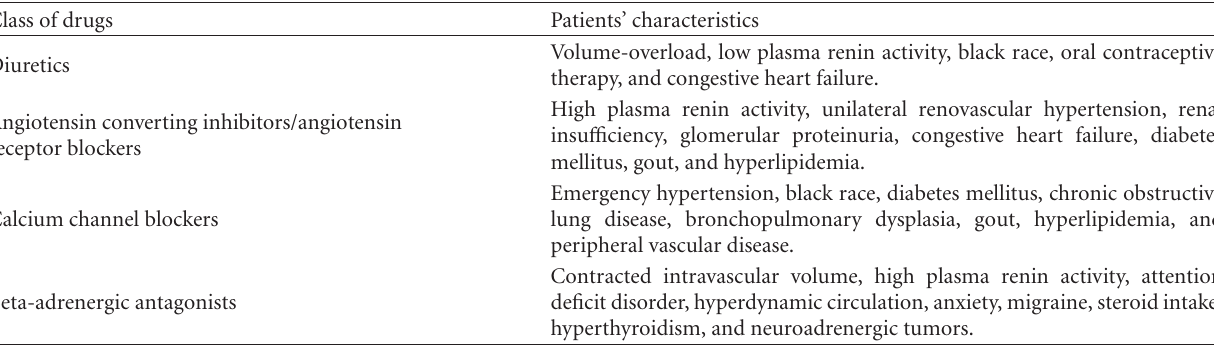
Table 3: Drug options for initial therapy for hypertension in children.